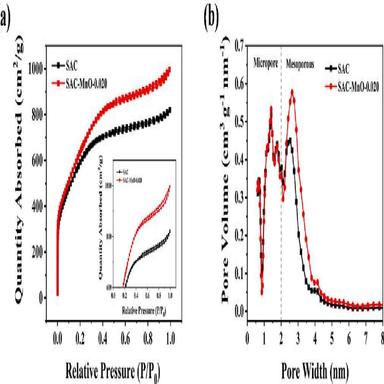
(a) N2 absorption-desorption isotherms; (b) Pore size distribution of SAC and SAC-MnO-0.020.